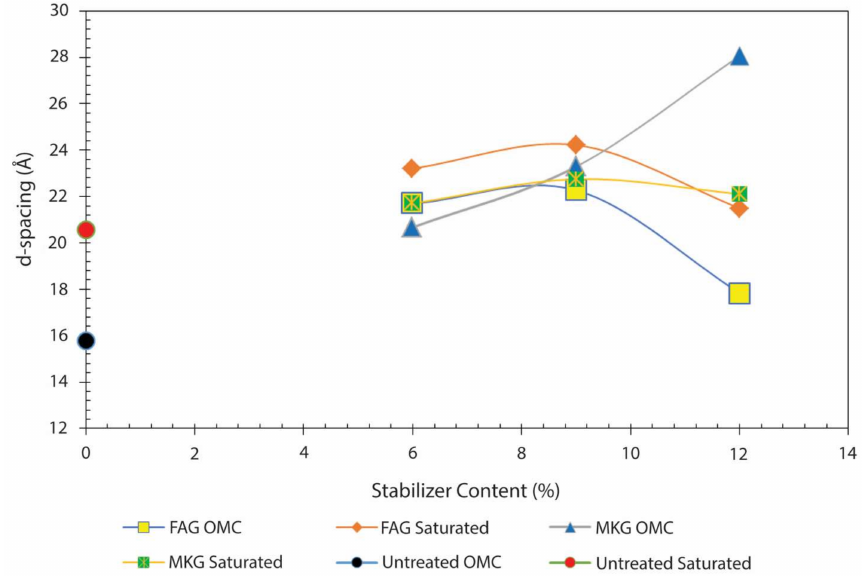
Figure 6. Change in the d-spacing (Å) for montmorillonite after the addition of different percentages of stabilizer (MKG and FAC) compared with untreated samples under optimum moisture content (OMC) and saturated